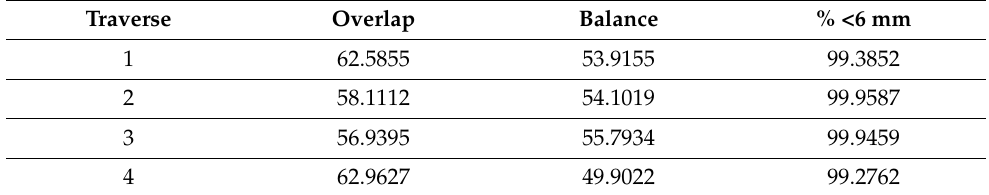
Table 1. Summary of the quality obtained in the four itineraries carried out with the BLK360 scanner. Traverse Overlap